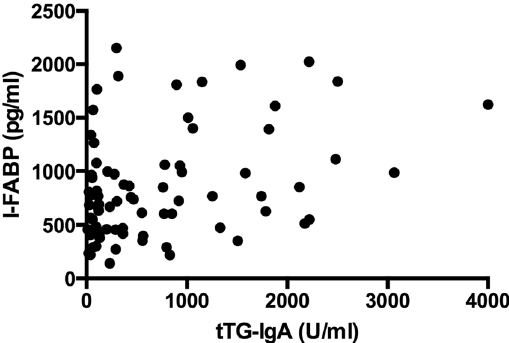
Figure 6. Correlation between plasma I-FABP levels and serum tTG-IgA titres at time of